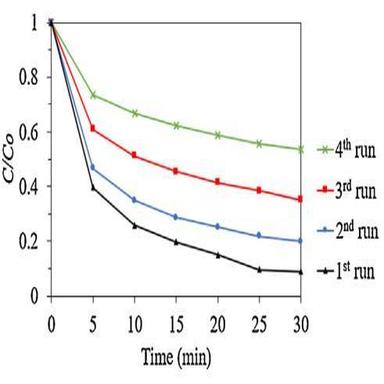
Reusability potential of the optimized HBC/nZVI for pNDA bleaching in four consecutive cycles (initial pNDA concentration = 10mM, adsorbent dose = 250 mg L1 ).